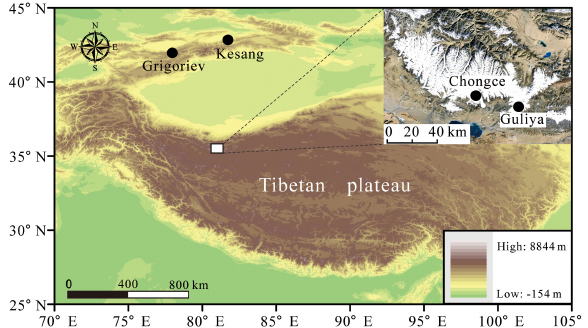
Figure 1. Study area map showing the locations of the Chongce and Guliya ice caps, the Kesang cave and the Grigoriev ice